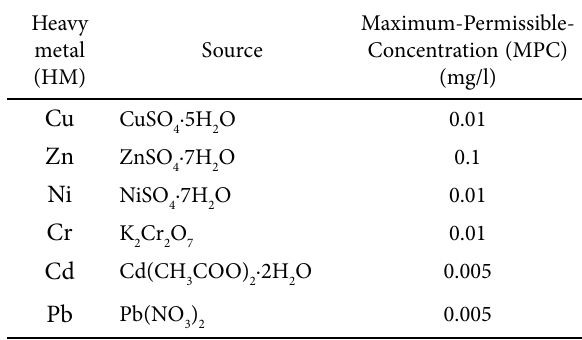
Table 1. Heavy metal (HM) concentrations in a model mixture Heavy metal (HM)